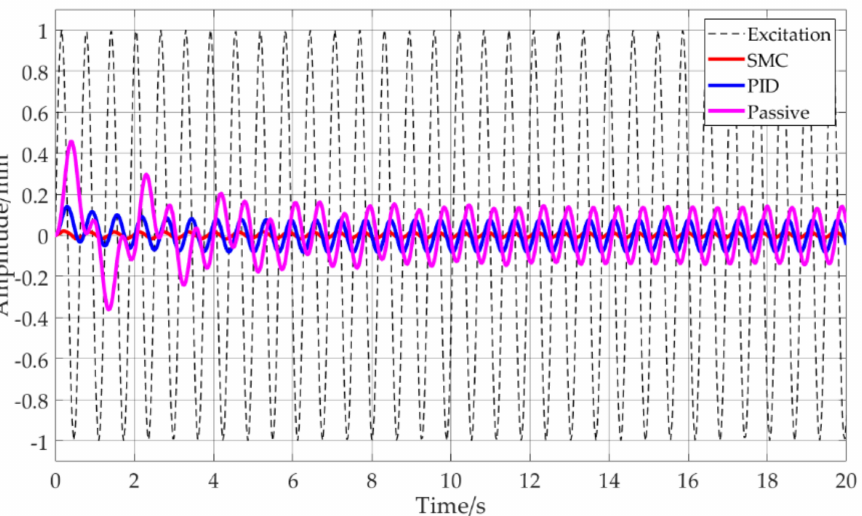
Figure 8. Comparison of the SMC, PID and the passive system under excitation of a sinusoidal signal with an amplitude of 1 mm and a frequency of 10